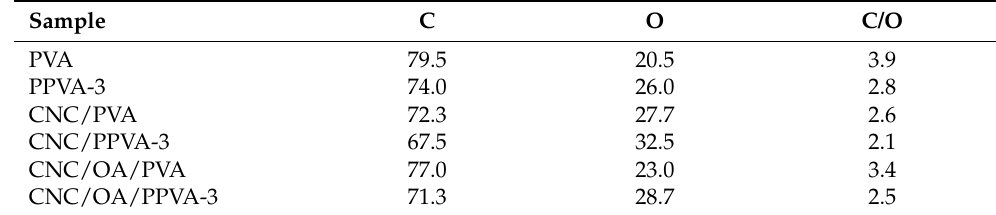
Figure 3. Contact angles of different films treated without or with air plasma. Table 1. Atomic composition and C/O ratios of different films without or with air plasma